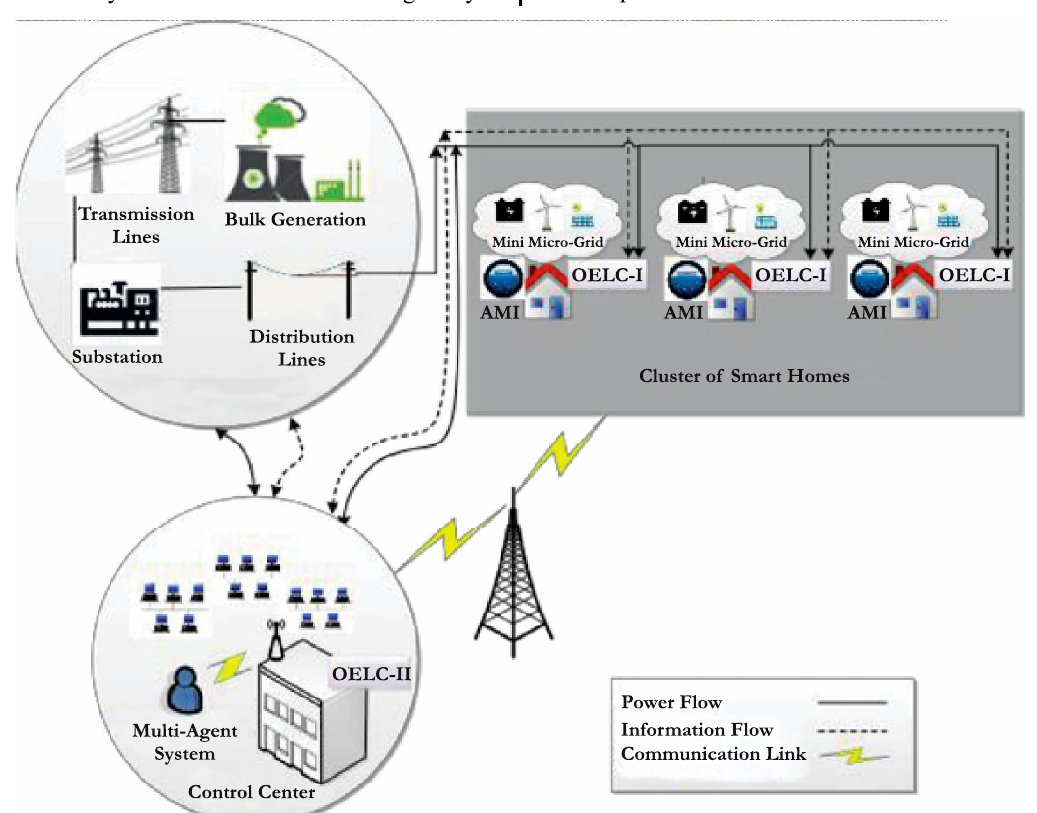
FIG. 1. PROPOSED SYSTEM MODEL FOR OELC WITH MULTI-AGENT SYSTEM AT BOTH PRODUCTION AND CONSUMPTION